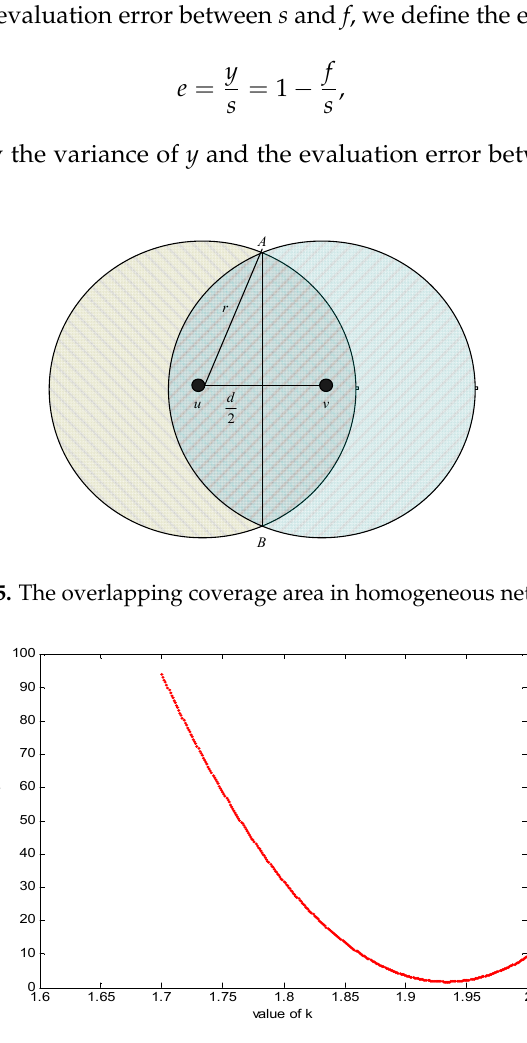
Figure 6. The variance of the difference between s and f under different value of k. Appl. Sci. 2016 , 6 , 396